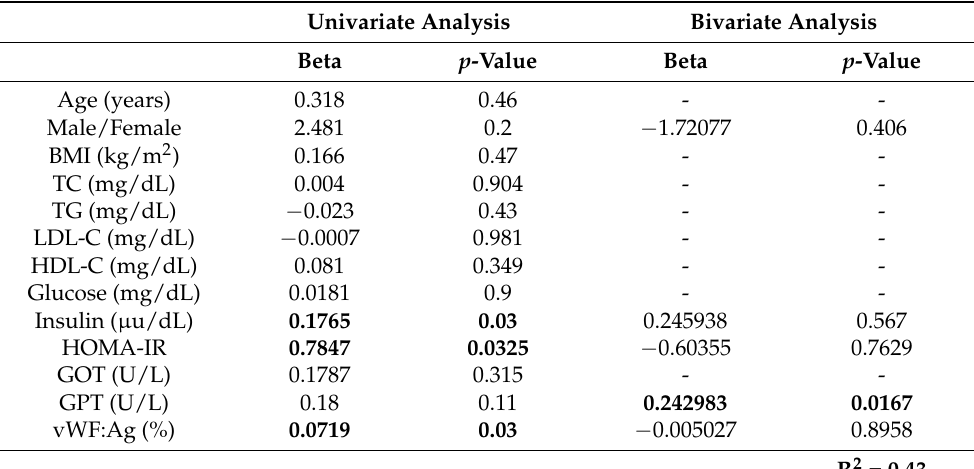
Table 2. Multivariate analysis with the characteristics of the children